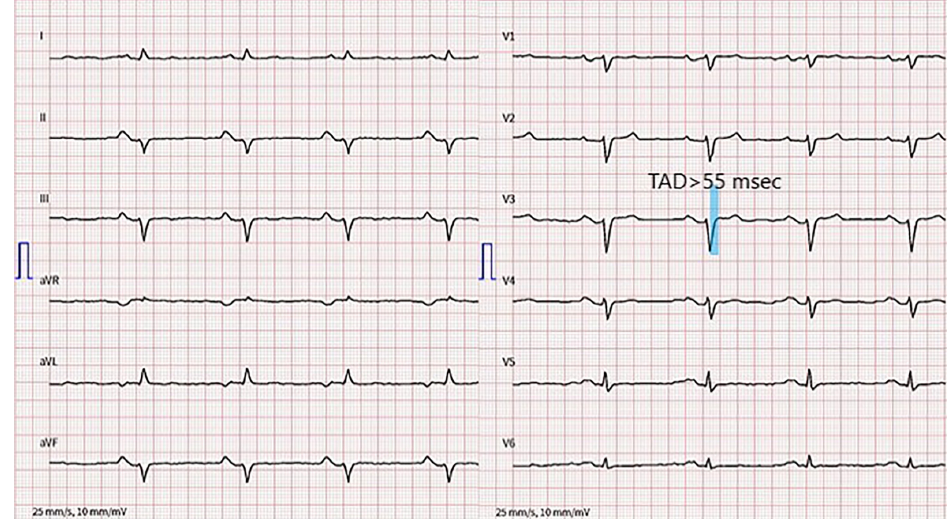
Figure 3. 12-lead electrocardiogram. Terminal activation duration delay in V1–V3, left anterior hemiblock and PR prolongation are present.